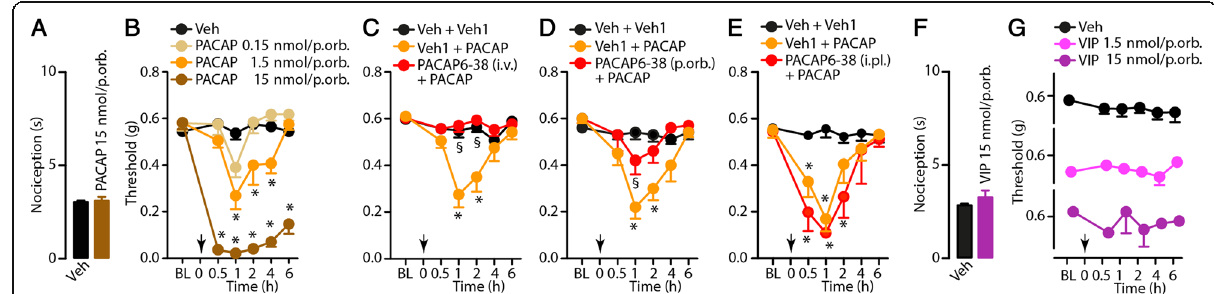
Fig. 2 a PACAP periorbital (p.orb., 10 μ l/15 nmol/site) injection does not evoke spontaneous nociceptive behaviour. b Dose- and time-dependent periorbital mechanical allodynia (PMA) evoked by p.orb. Injection of PACAP (10 μ l/0.15 – 15 nmol/site). c - e Effect of pretreatment with intravenous (i.v., 12 nmol/kg), p.orb. (10 μ l/240 pmol/site) or intraplantar (i.pl., 20 μ l/240 pmol/site pmol) PACAP6 – 38 on PMA evoked by PACAP (p.orb., 10 μ l/ 1.5 nmol/site). VIP injection (p.orb., 10 μ l/1.5 and 15 nmol/site) does not evoke spontaneous nociceptive behaviour ( f ) or PMA ( g ). C57BL/6J mice were used. Veh is the vehicle of PACAP ( a - e ) or VIP ( f , g ) and veh1 is the vehicle of PACAP6 – 38 ( c - e ). Arrows indicate time of PACAP or